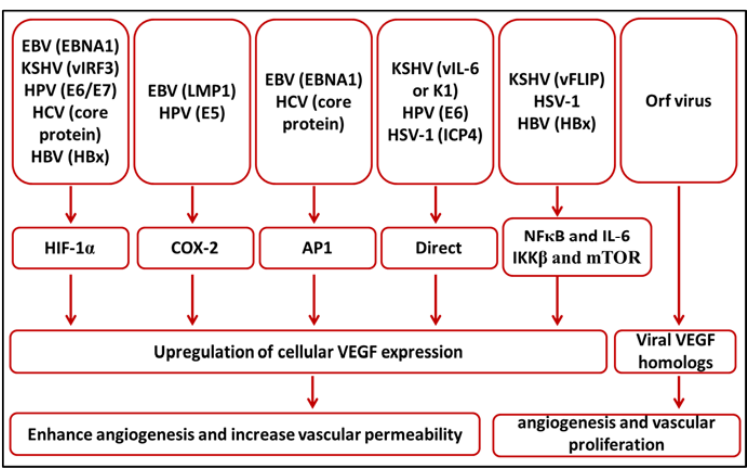
Figure 1. A schematic diagram summarizes how different viruses mediate vascular endothelial growth factor (VEGF)